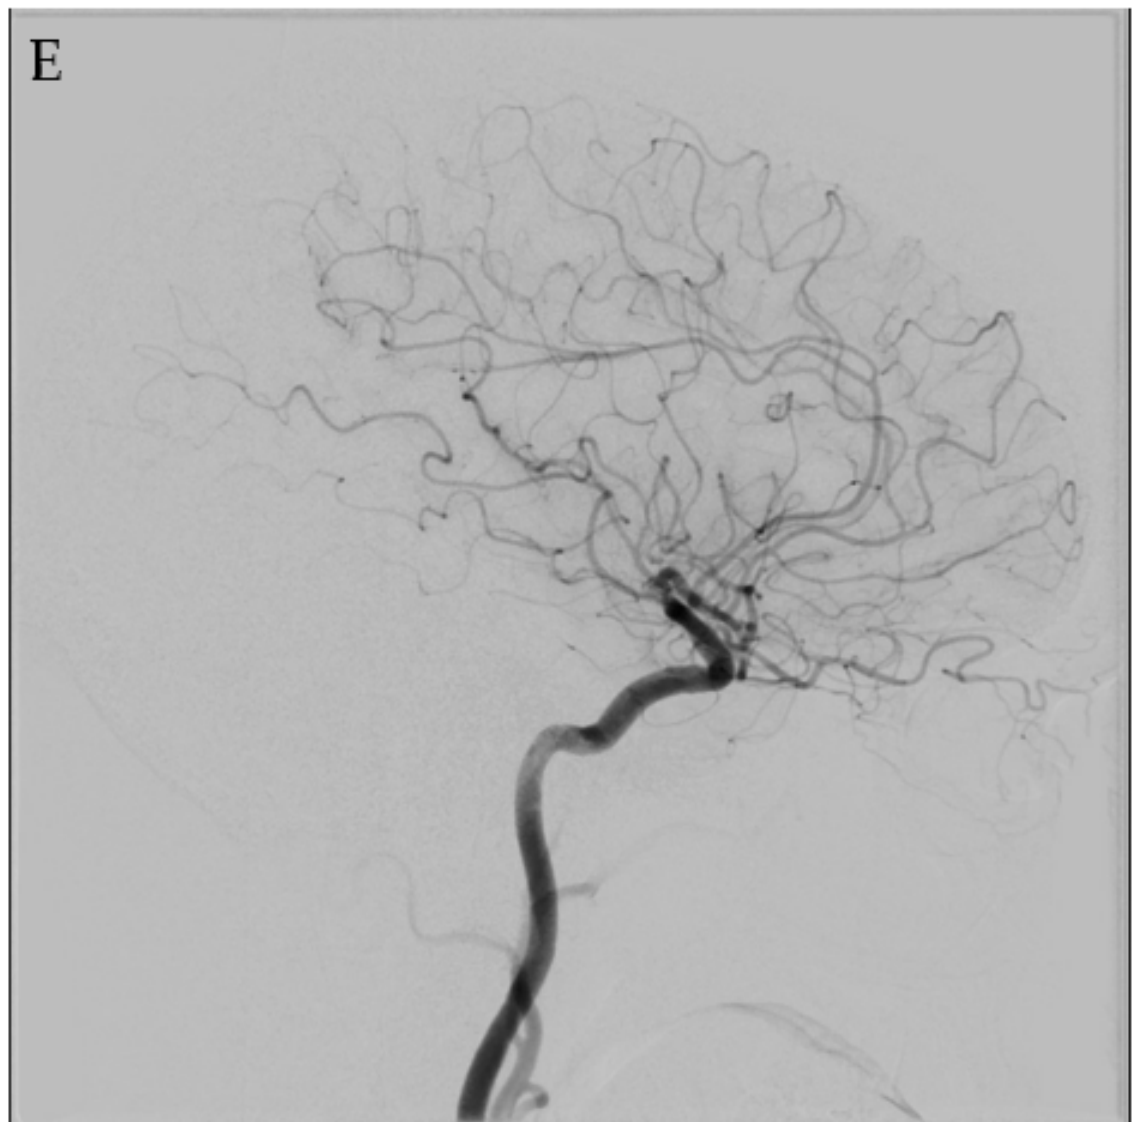
Figure 3. A 48-year-old male who presented with a seizure found to have an unruptured left poste- rior temporal lobe SM grade II AVM with arterial supply from the left middle cerebral artery (MCA), PCA, and left middle meningeal artery (MMA) ( A , B ). Given the location of the lesion, a WADA